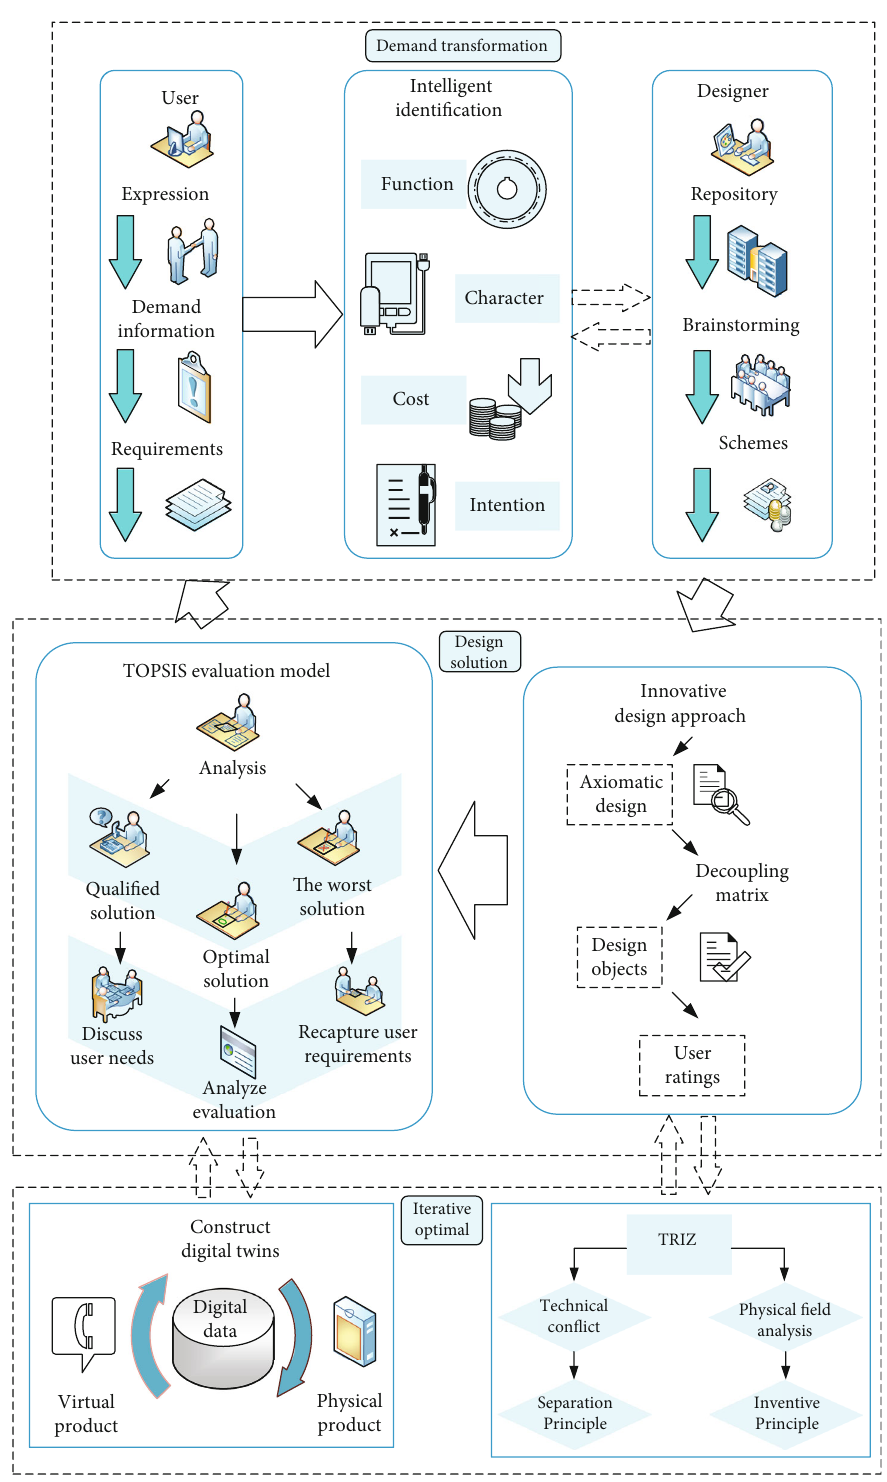
Figure 3: The design process model based on digital twin technology. The speci fi c design process model is shown in Figure 3.